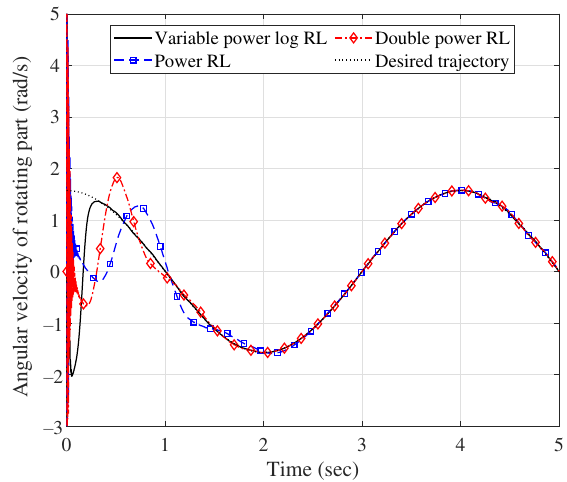
Figure 15. Angular velocity of rotating part (Group 2). Group 3: The results of the third group of simulations are presented in Figures 16–21.